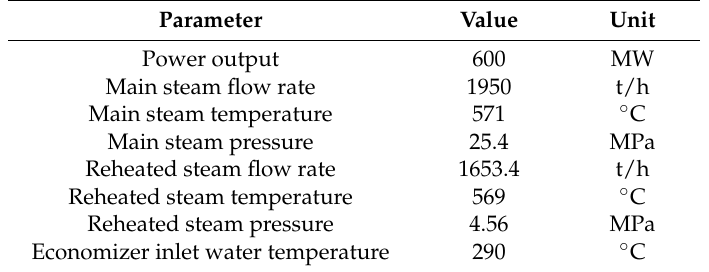
Table 1. Parameters of the 600 MW once-through supercritical coal-fired power plant.